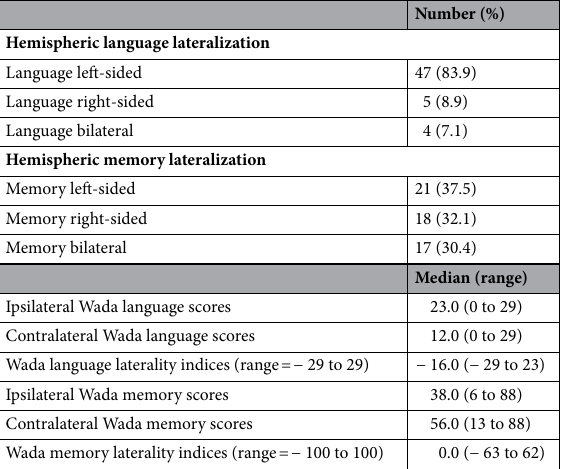
Table 2. Summary of Wada test scores and results regarding hemispheric language and memory lateralization.